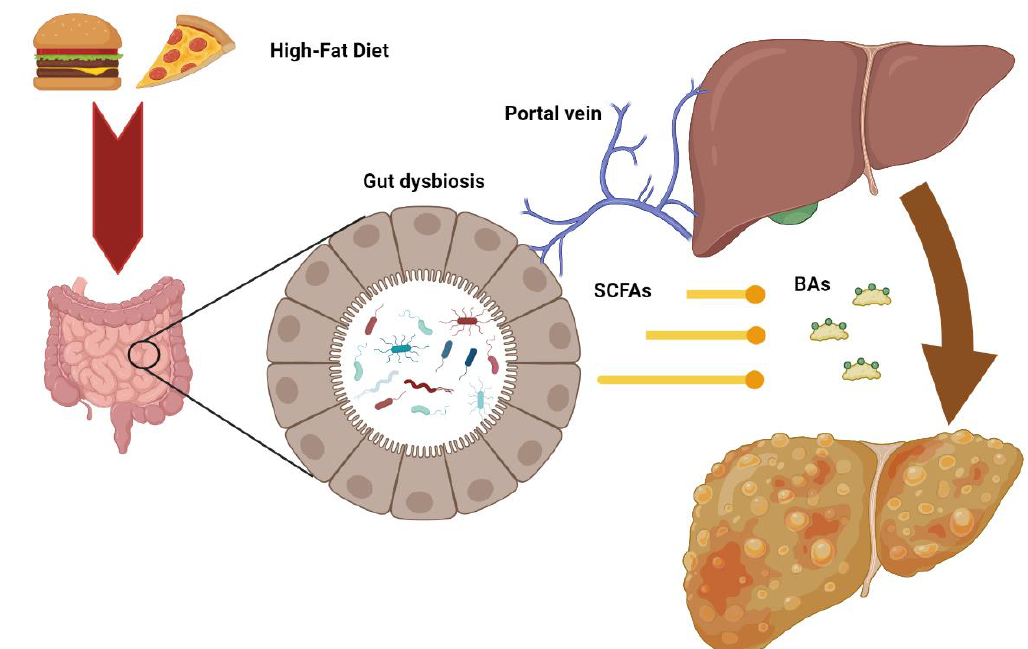
Figure 2. Intestinal dysbiosis consequent to metabolic alterations may increase the release of microbial metabolites such as short chain fatty acids (SCFD) and secondary bile acids (BAs) to the liver through the portal vein, contributing to the pathogenesis of hepatic